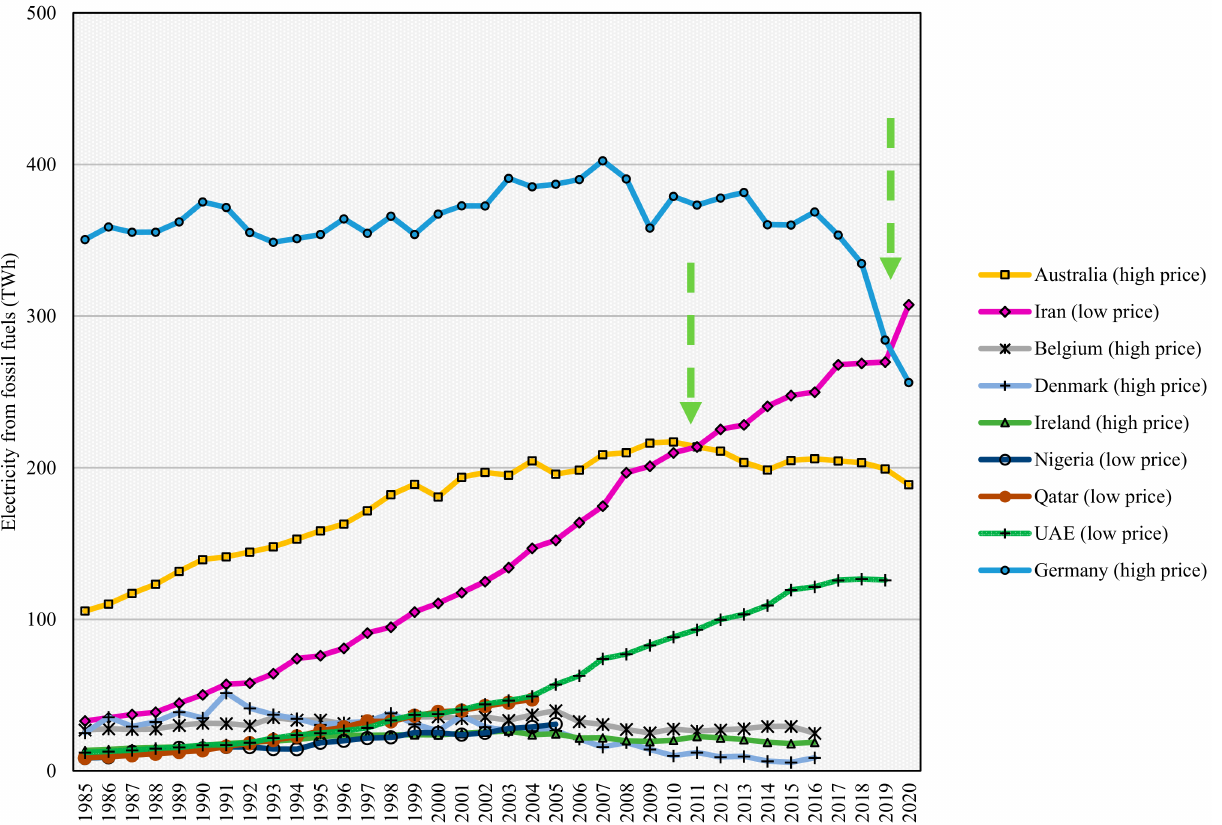
Figure 7. Comparing electricity generated from fossil fuels between countries with low and high electricity